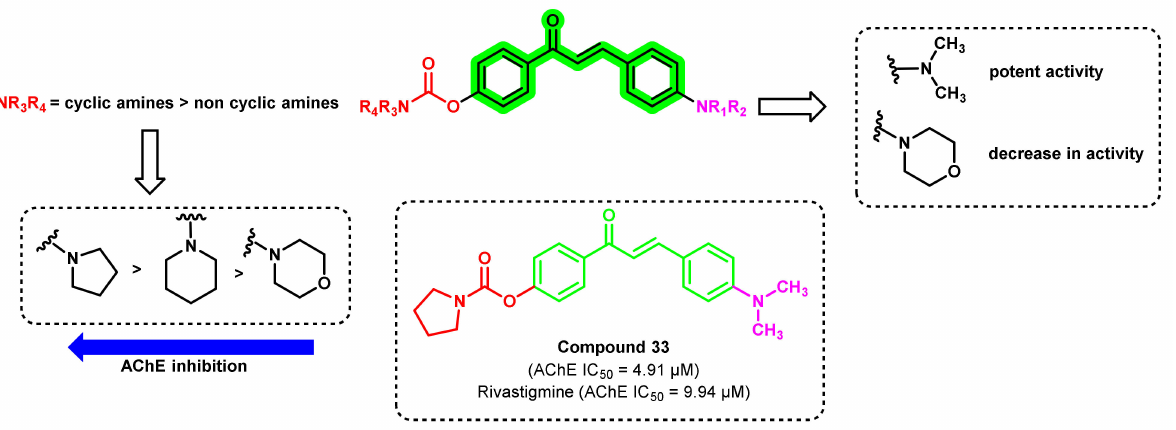
Figure 30. Chemical structures of 4-amino chalcone-rivastigmine